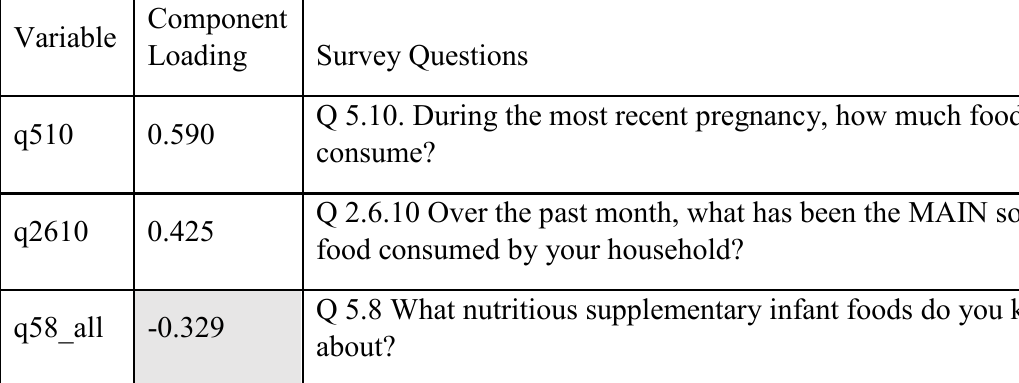
Table 1.20: Variables defining Absorptive Resilience